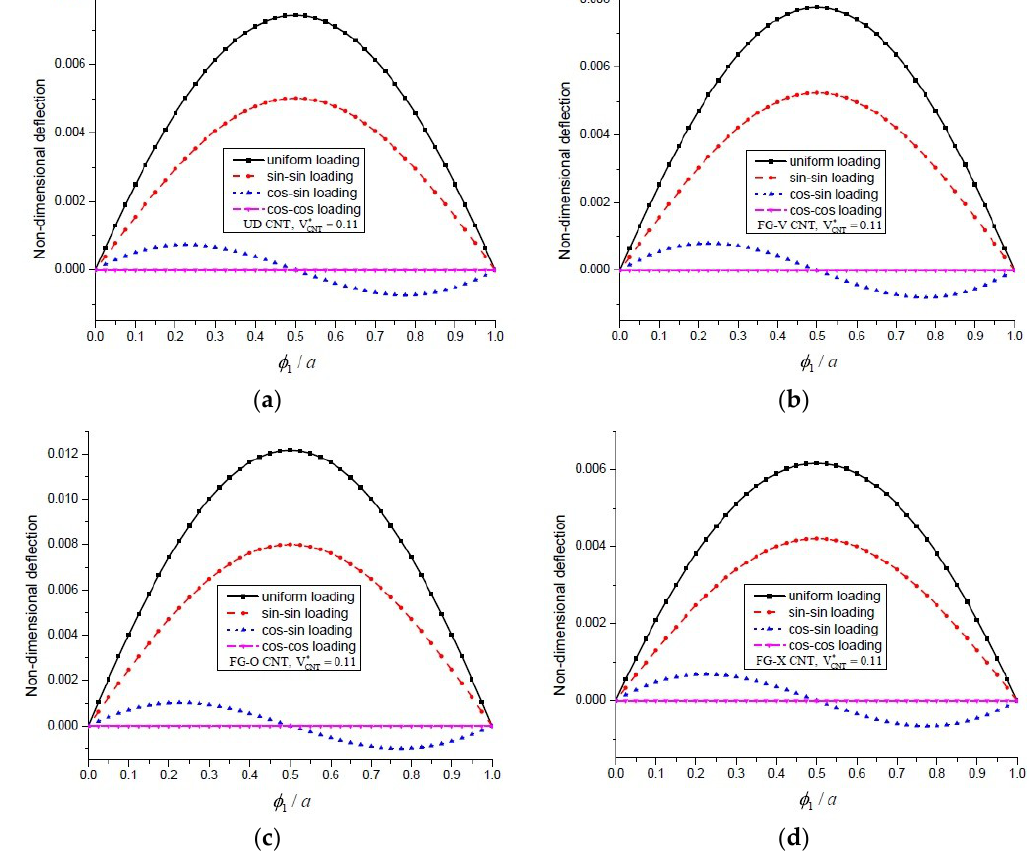
Figure 5. The variation of transverse deflection vs. the length φ 1 / a for an FG-CNT-reinforced plate, for ( a ) UD; ( b ) FG-V; ( c ) FG-O and ( d ) FG-X distribution subjected to sin-sin loading.